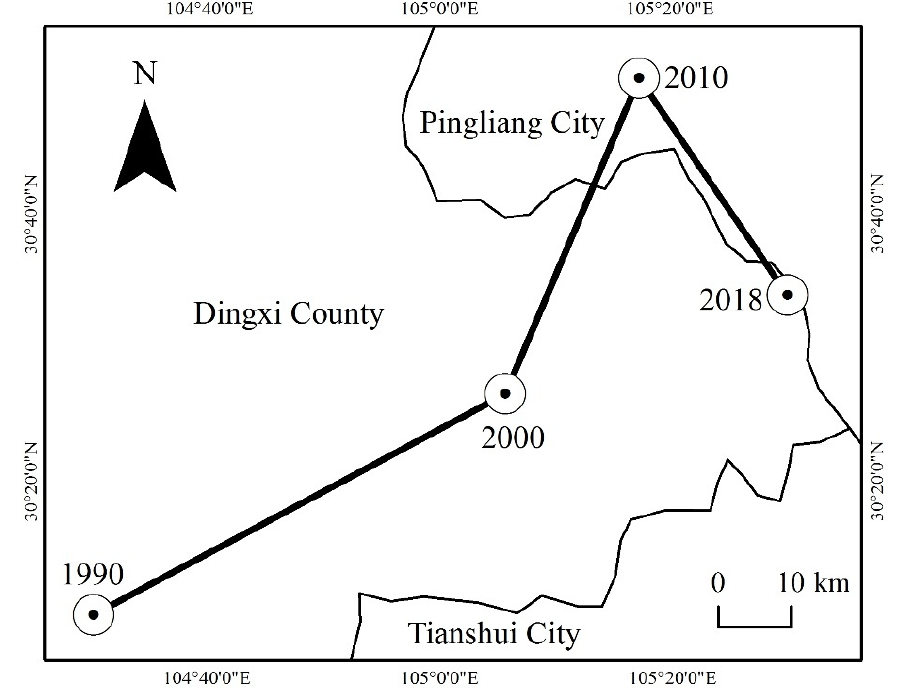
Figure 7. Barycenter evolution trajectory of ESV.